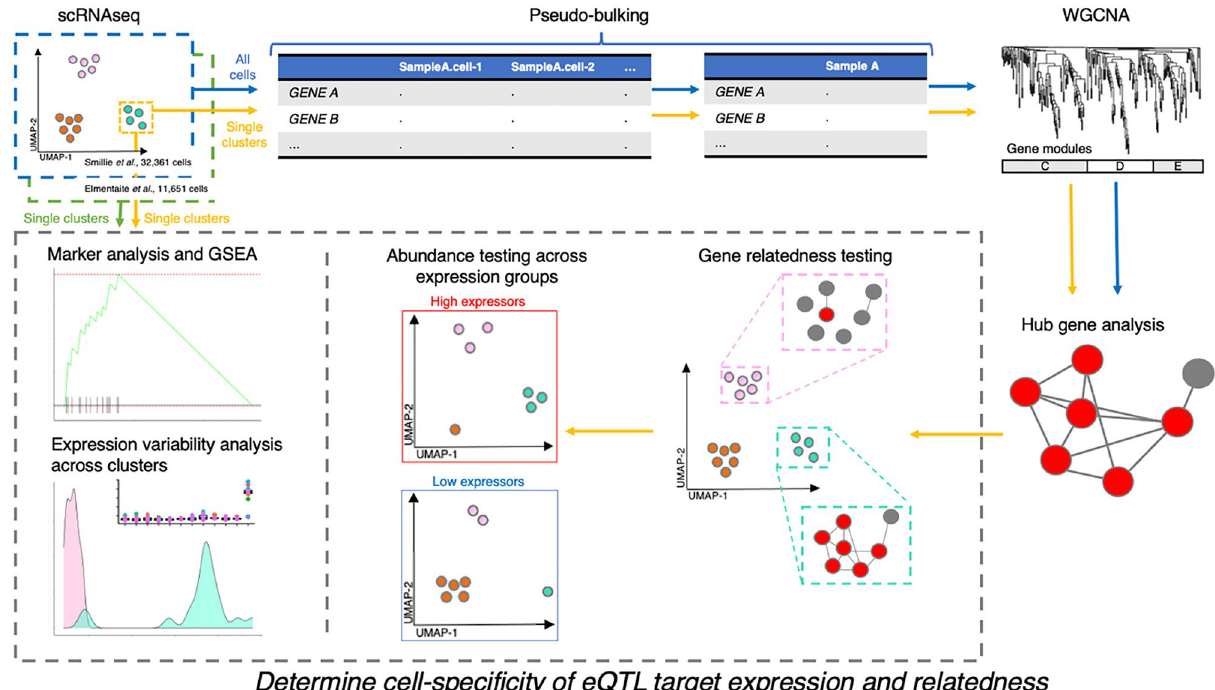
Figure 1. Overview of study design and analysis. This study makes use of two single cell RNA sequencing (scRNAseq) datasets: Smillie et al . 22 —n = 32,261 and Elmentaite et al . 23 —n = 11,651. The analysis performed on each dataset is outlined by arrow colour: blue = all cells from Smillie et al . 22 , yellow = individual clusters from Smillie et al . 22 , green = individual clusters from Elmentaite et al . 23 . WGCNA weighted gene co-expression network analysis, GSEA gene set enrichment